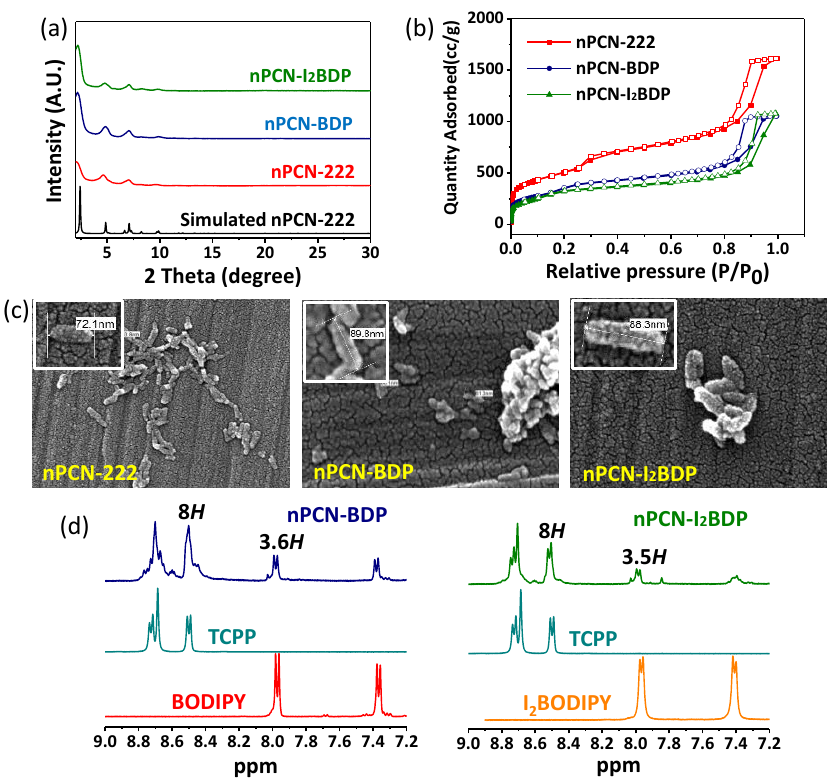
Figure 1. ( a ) PXRD patterns of nPCN-222, nPCN-BDP, and nPCN-I 2 BDP. ( b ) Surface area of nPCN-222, nPCN-BDP, and nPCN-I 2 BDP was determined from N 2 absorption-desorption isotherms. ( c ) SEM images of nPCN-222, nPCN-BDP, and nPCN-I 2 BDP; inset shows the size of each MOF, which was consistently below 100 nm. ( d ) NMR data for nPCN-BDP and nPCN-I 2 BDP.